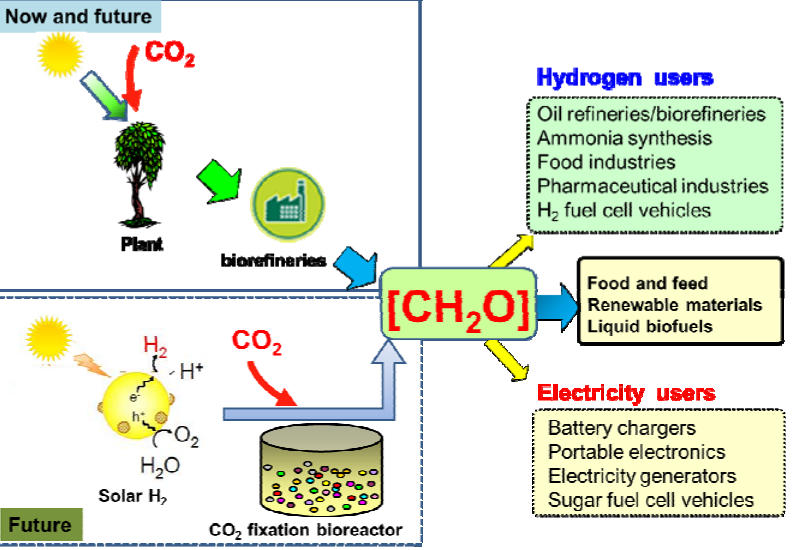
Figure 4. The carbon-neutral carbohydrate economy linked with its current and future productions and